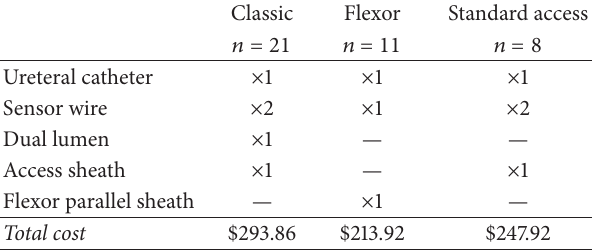
Table 1: Most commonly used techniques for gaining upper tract